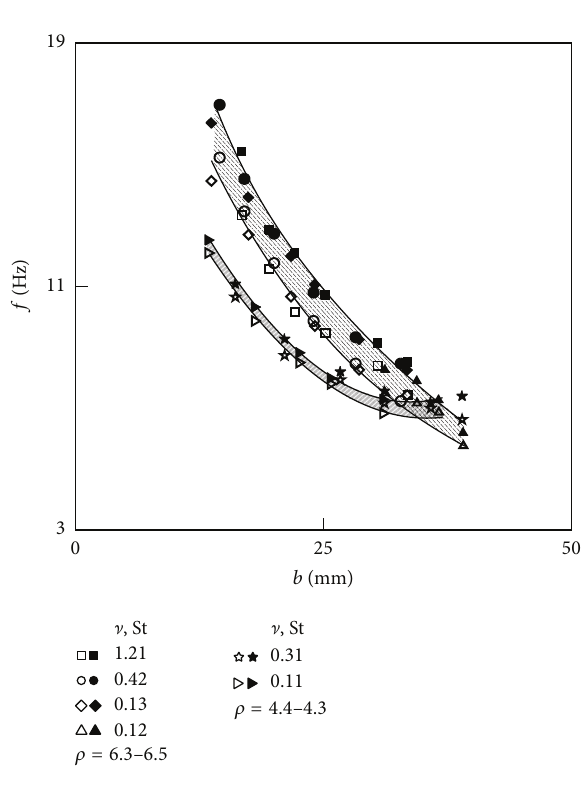
Figure 4: The boundaries of transitions in the suspended state for the bodies of different relative density in the fluids of different